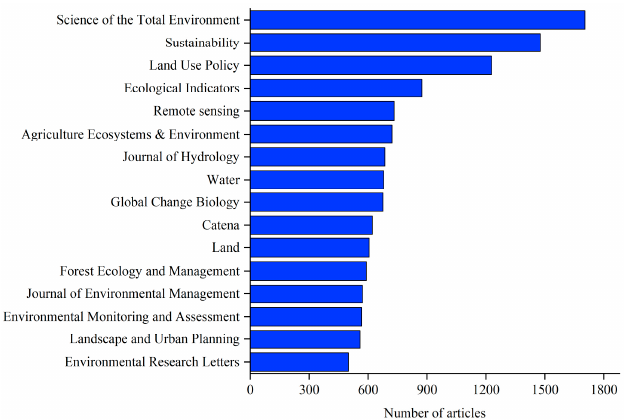
Figure 2. Top ten journals for article publication reviewed in this study.